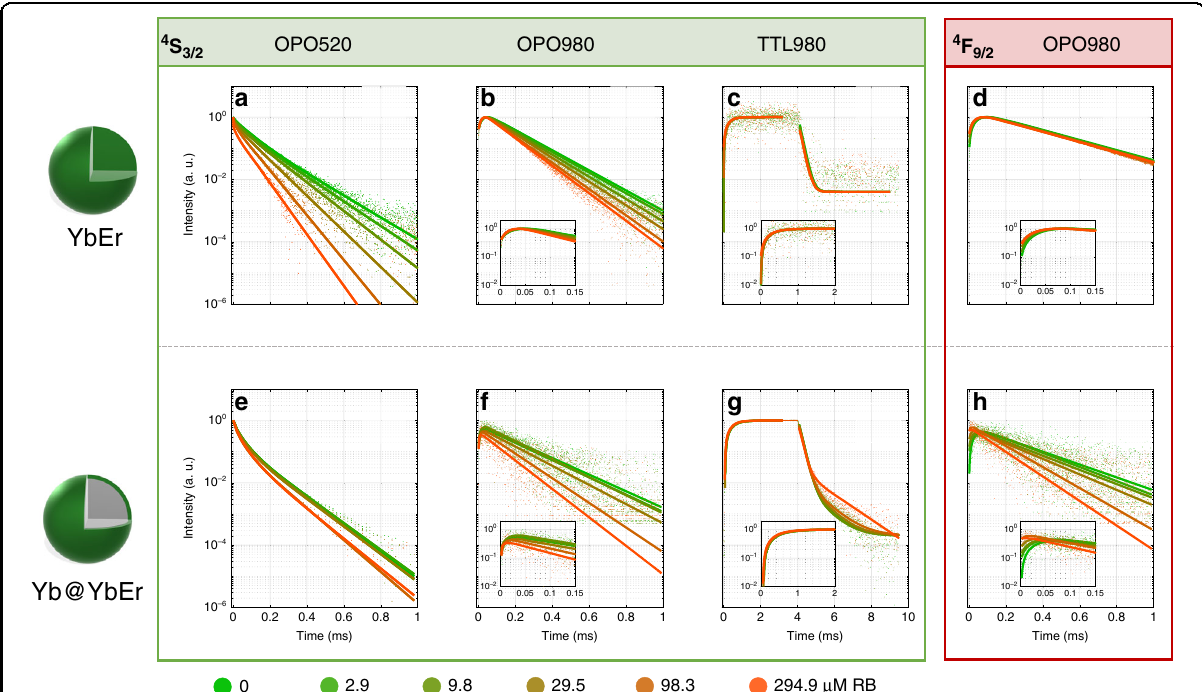
Fig. 3 Qualitative comparison of luminescence kinetics of YbEr and Yb@YbEr samples undergoing in UC-LRET. Luminescencekinetics for emission of energy levels. 4 S 3/2 (525 – 550 nm) and 4 F 9/2 (650 nm) emission from ( a – d ) YbEr core only and ( e – h ) Yb@YbEr core-shell UCNPs, respectively, at a rising concentration (0, 2.9, 9.8, 29.5, 98.3, and 294.8 µM) of Rose Bengal attached on their surface. Various excitation modes were compared: a , e 520 nm 10 ns pulse from OPO laser; b , d , f , h 980 nm 10 ns pulse from OPO laser; c , g 980 nm 4 ms pulse from TTL controlled 10 W CW laser diode. Additionally, luminescence decays of 4 F 9/2 level emission of Er 3 + under 980 nm with 10 ns pulse from OPO are shown ( d , h ). The insets contain magni fi ed rise time regions on the corresponding kinetic pro fi les. A complete set of data for green and red emissions is presented in